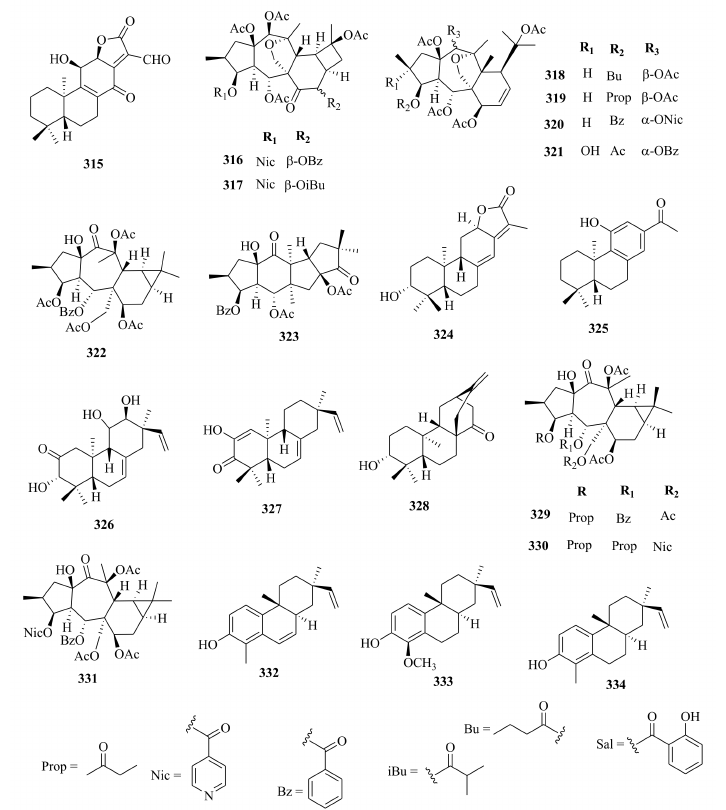
Figure 13. Mysrinane, premyrsinane, rosane and paralianone, pimarane, and tigliane diterpenoids.